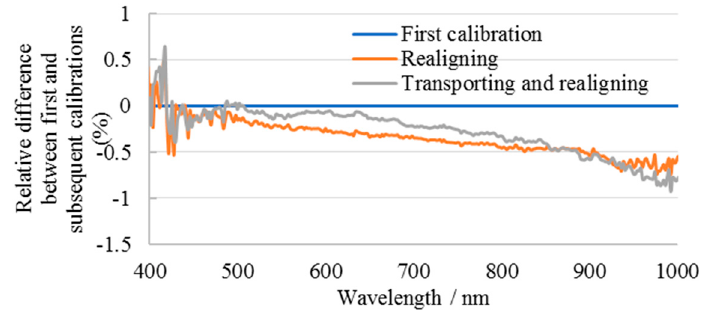
Figure 7. Relative difference in the calibration following realignment and realignment and transportation.